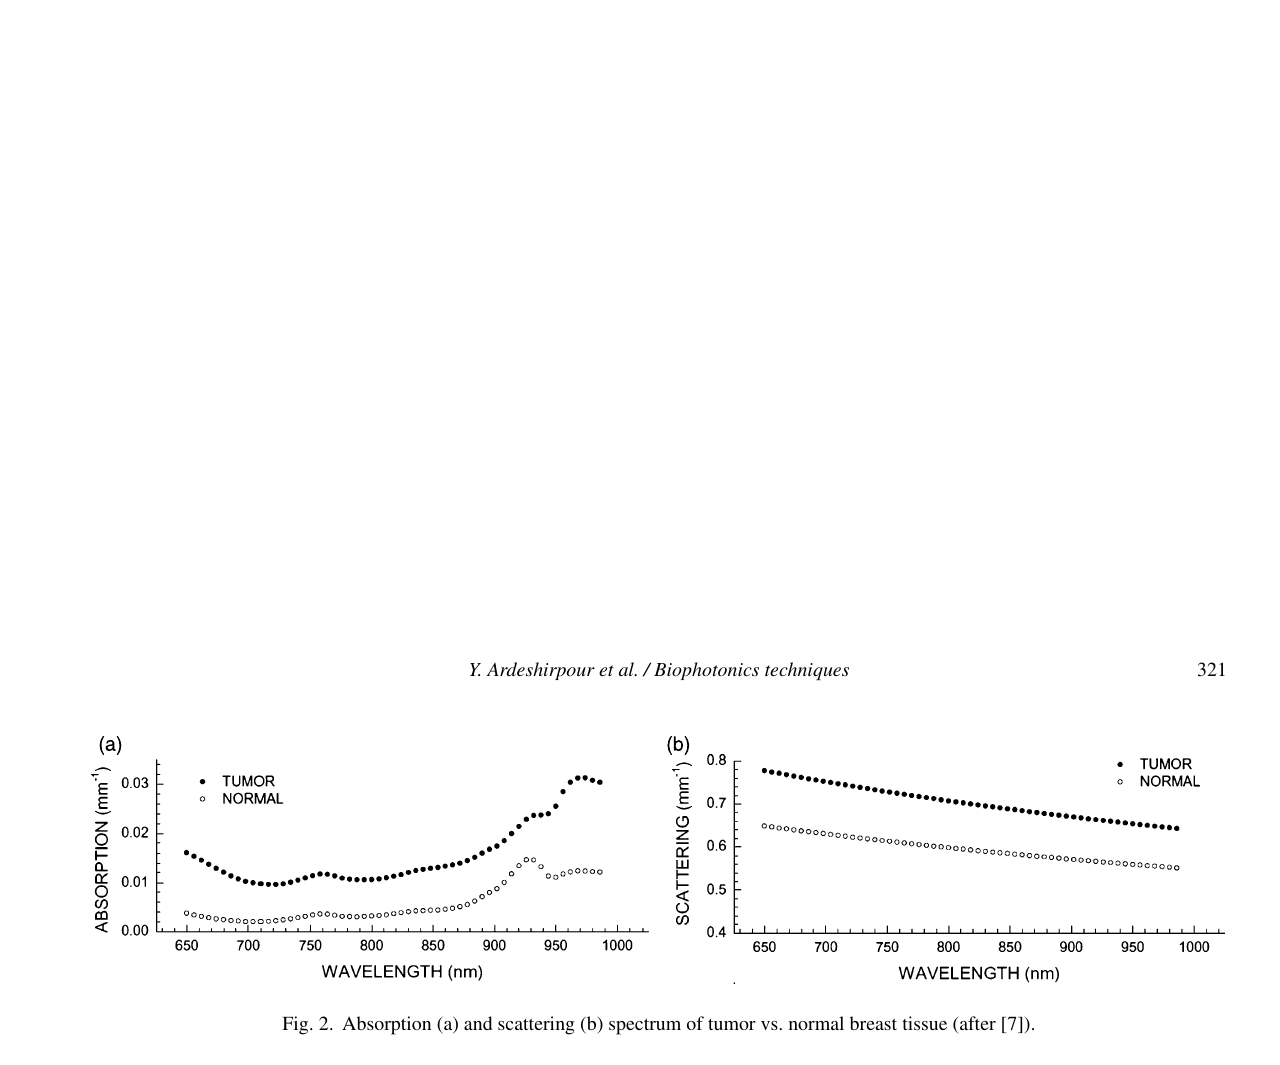
breast tissue in near infrared spectrum [7]. The data